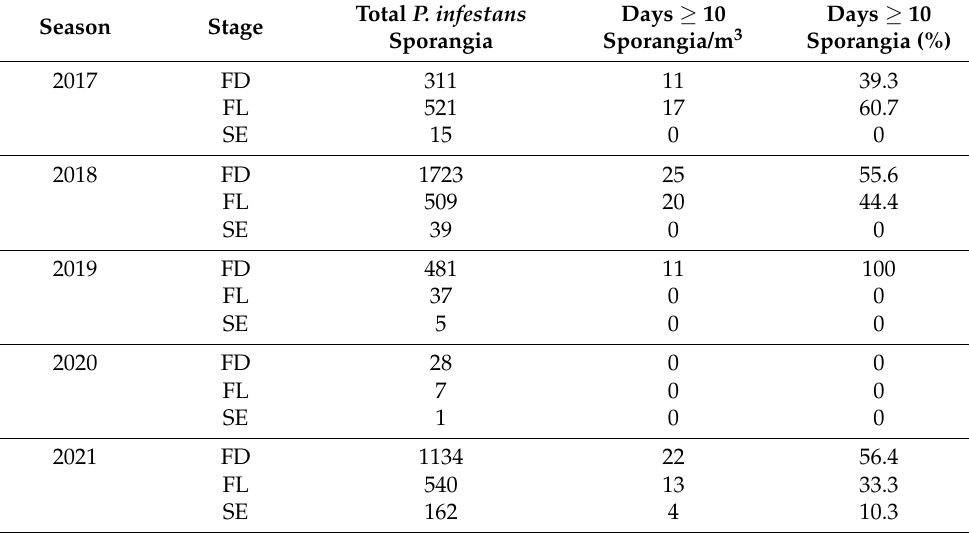
Temperature (T) and relative humidity (RH) expressed in mean values. Table 3. Sporangia information by phenological stage during the five studied crop seasons. Total P. infestans Season Stage